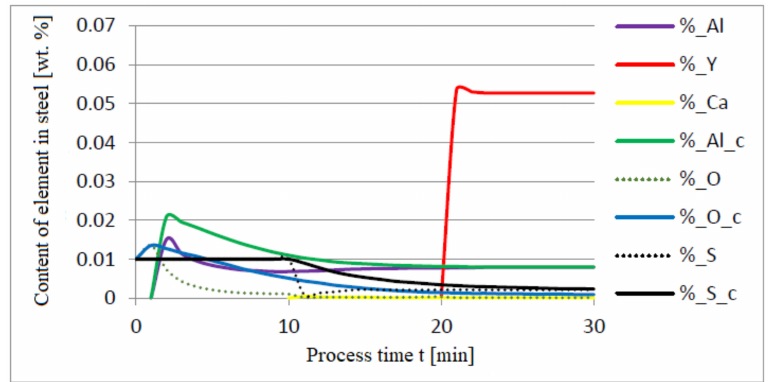
Figure 8. Change in the content of an element in liquid steel (wt.%) depending on the process time t